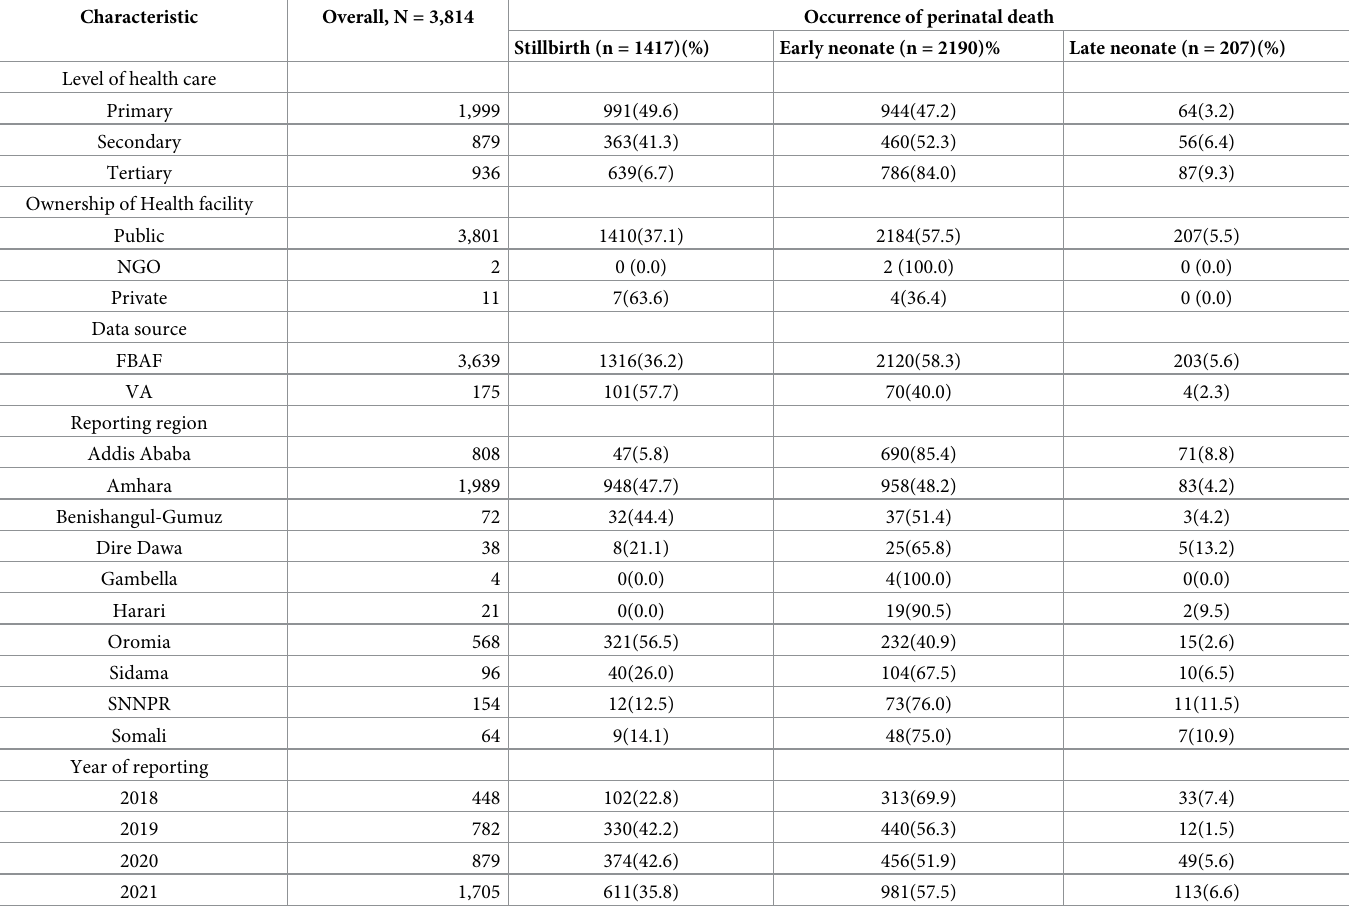
Table 4. Selected background characteristics of reporting facilities by the timing of death in